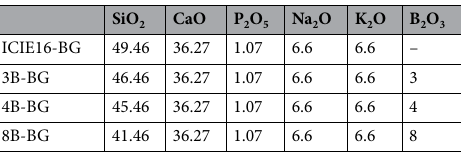
Table 1. Chemical composition of BGs used in the experiments (in